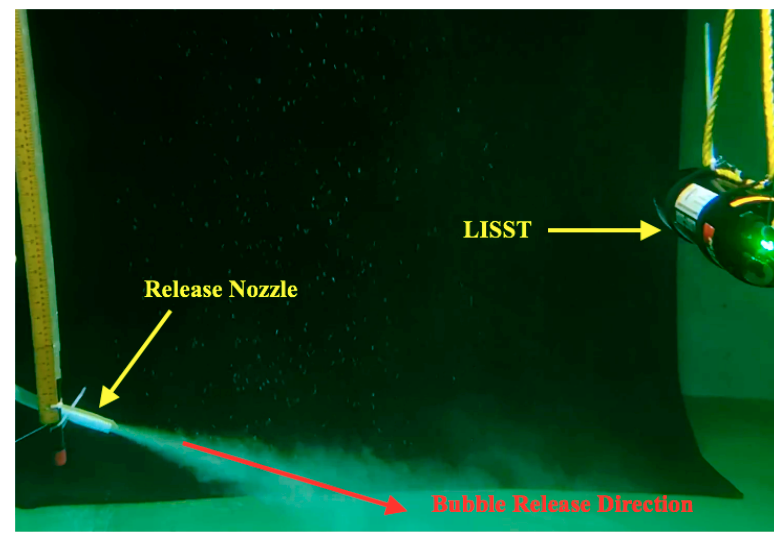
Figure 11. Bubbles released from the nozzle.